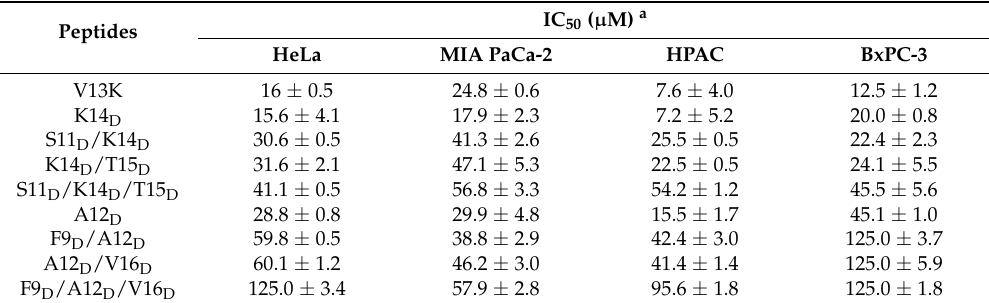
Table 4. IC 50 of peptides against cancer cell